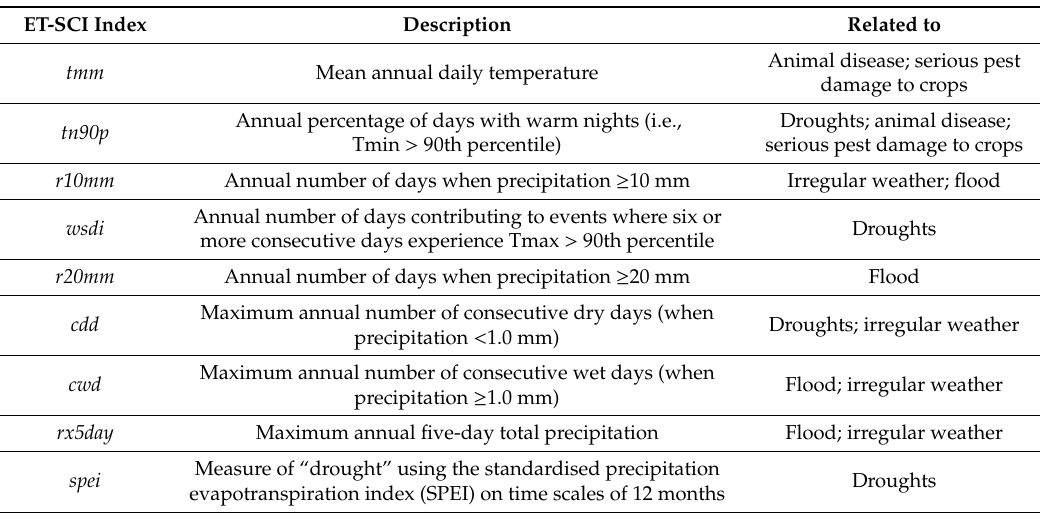
Table 2. ET-SCI indices analyzed to understand trends in climate shocks in Western Nepal (Source: modified after